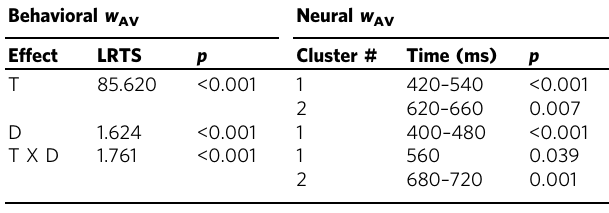
Note: p values are based on randomization tests using a circular log likelihood-ratio statistic (LRTS). Effects for the neural w AV are cluster-based corrected for the multiple time points. Only signi fi cant (i.e. p <0.05) clusters are reported. n =